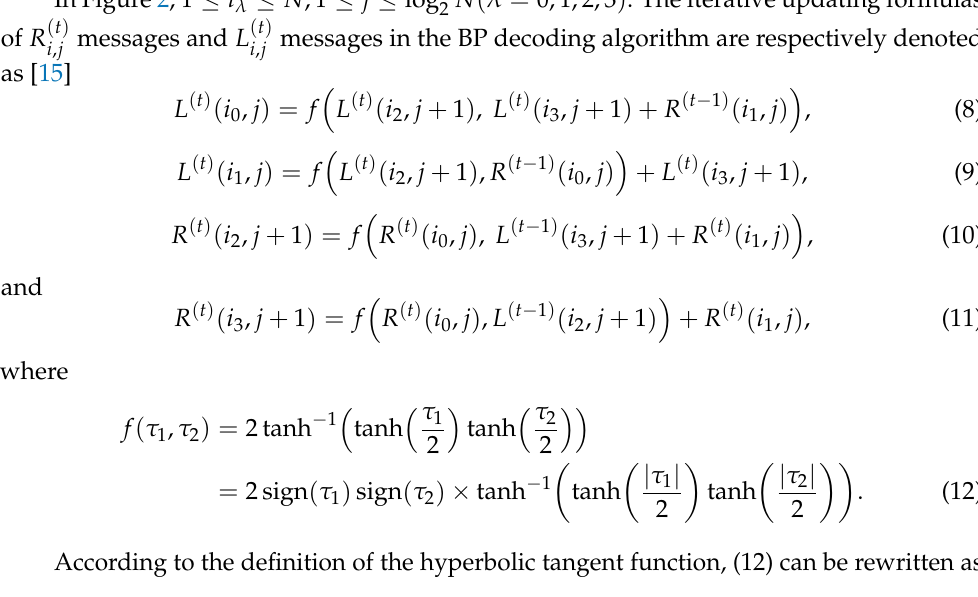
Figure 2. The basic computational block of the BP algorithm for a polar code. N ( λ = 0, 1, 2, 3 ) . The iterative updating In Figure 2, 1 ≤ i λ ≤ N , 1 ≤ j ≤ log 2